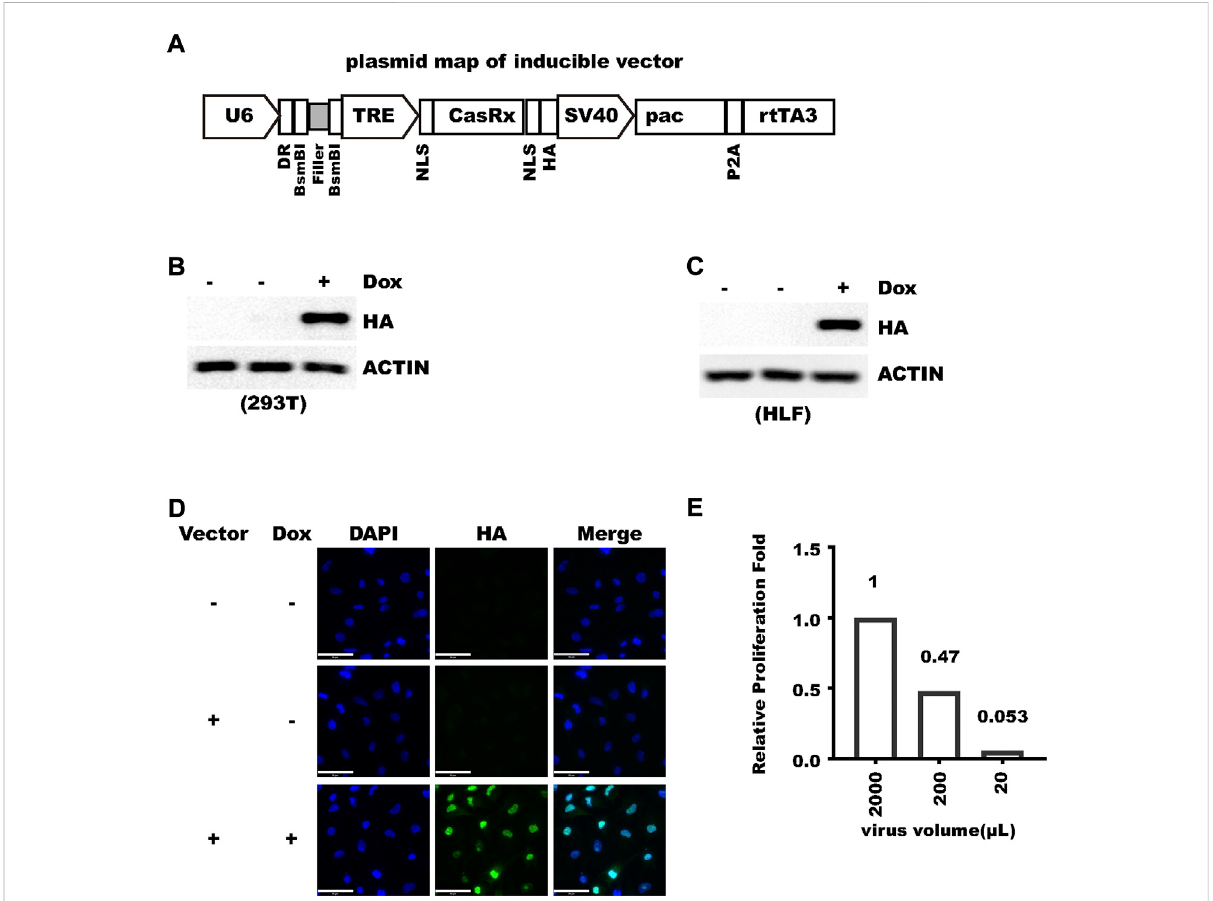
pLenti-TRE-CasRx-U6 expresses CasRx in a tightly-inducible manner. (A) Schematic representation of plenti-TRE-CasRx. (B) A total of 293Tcells weretransfected with pLenti-TRE-CasRx;24 hlater, thecellsweretreated with1 μ g/mlDoxycyclinefor 24 h. ShownareWBresults. First lane shows Donor cell. (C) HLF cells were transduced with a virus expressing pLenti-TRE-CasRx. Cells were selected with 1 μ g/ml puromycin for 5 days and then treated with 1 μ g/ml Doxycycline for 24 h. Shown are WB results. First lane shows Donor cell. (D) HLF cells were transduced with a virus expressing pLenti-TRE-CasRx; 48 h later, the cells were treated with 1 μ g/ml Doxycycline for 24 h. Shown are immuno fl uorescence results. Nuclei were counter-stained with DAPI. Scale bar: 50 μ m. (E) HLF cells were transduced with different volumes of virus suspension and then selected with puromycin. Cell proliferation during 4 days was counted and normalized to the cells infected with 2 ml virus which was con fi rmed to express HA-CasRx at about 100% with immuno fl